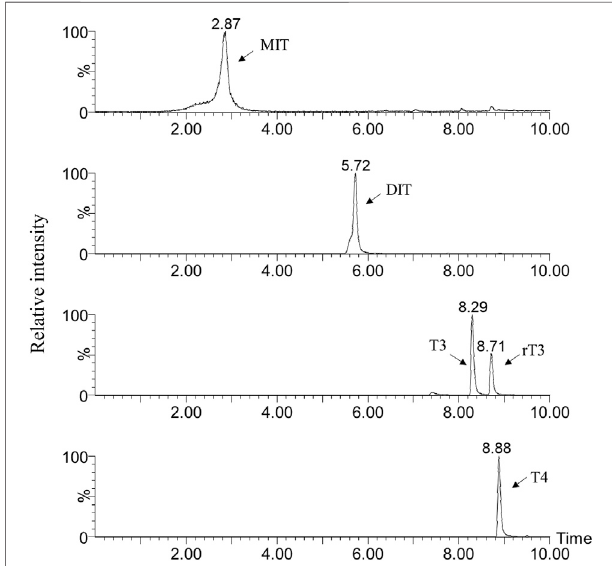
FIGURE 3 | UPLC-MS/MS chromatograms of the target thyroid hormones in standard solutions.